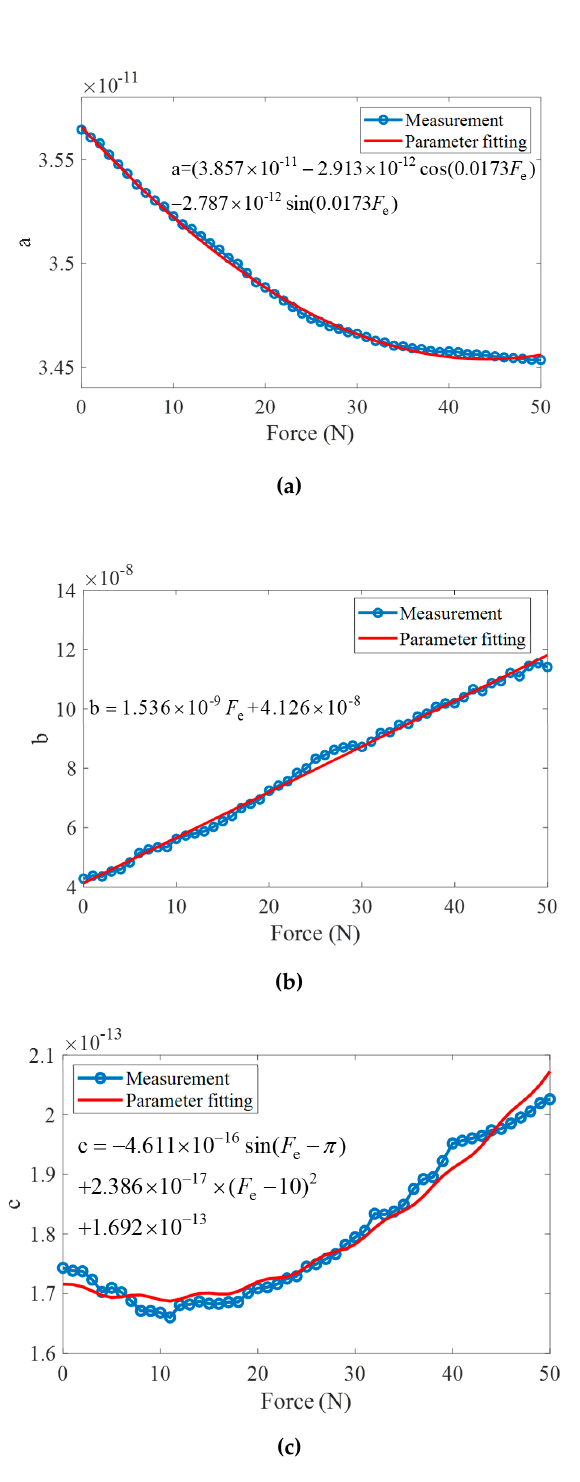
Figure 11. The estimated parameters of transfer function. ( a ) Parameter: a; ( b ) Parameter: b; ( c ) Parameter: c.